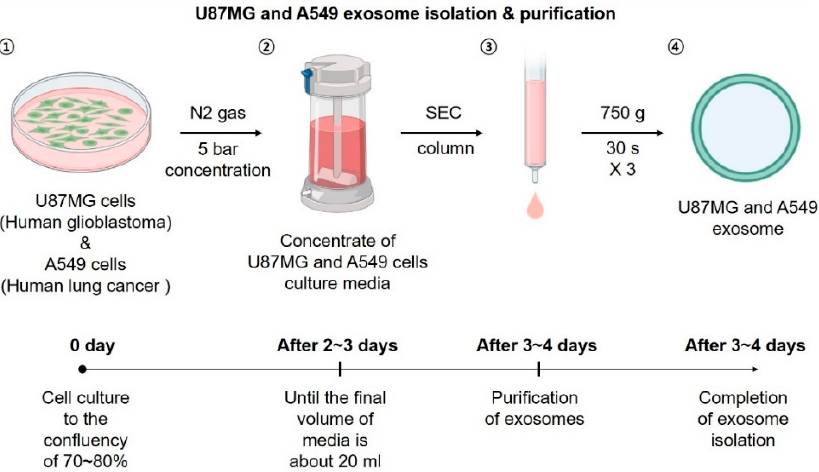
Figure 2. Scheme and time course of exosome